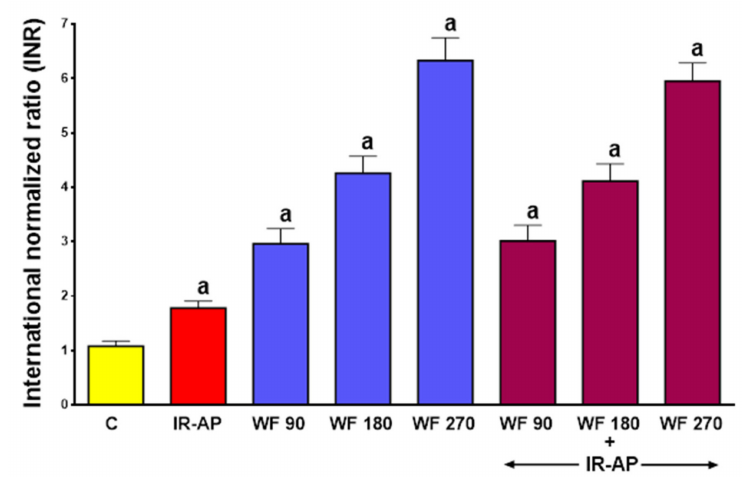
Figure 1. Impact of ischemia / reperfusion-induced acute pancreatitis (IR-AP) or / and pretreatment with warfarin given at a dose of 90, 180 or 270 µ g / kg / dose (WF 90, WF 180 or WF 270) on the international normalized ratio (INR). Mean ± SEM. n = 10 animals in each experimental group. a p < 0.05 compared to control